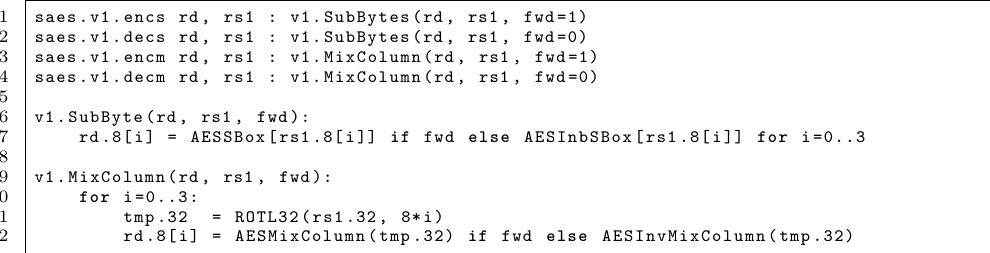
Figure 2: Instruction mnemonics, and their mapping onto pseudo-code functions, for V 1 .